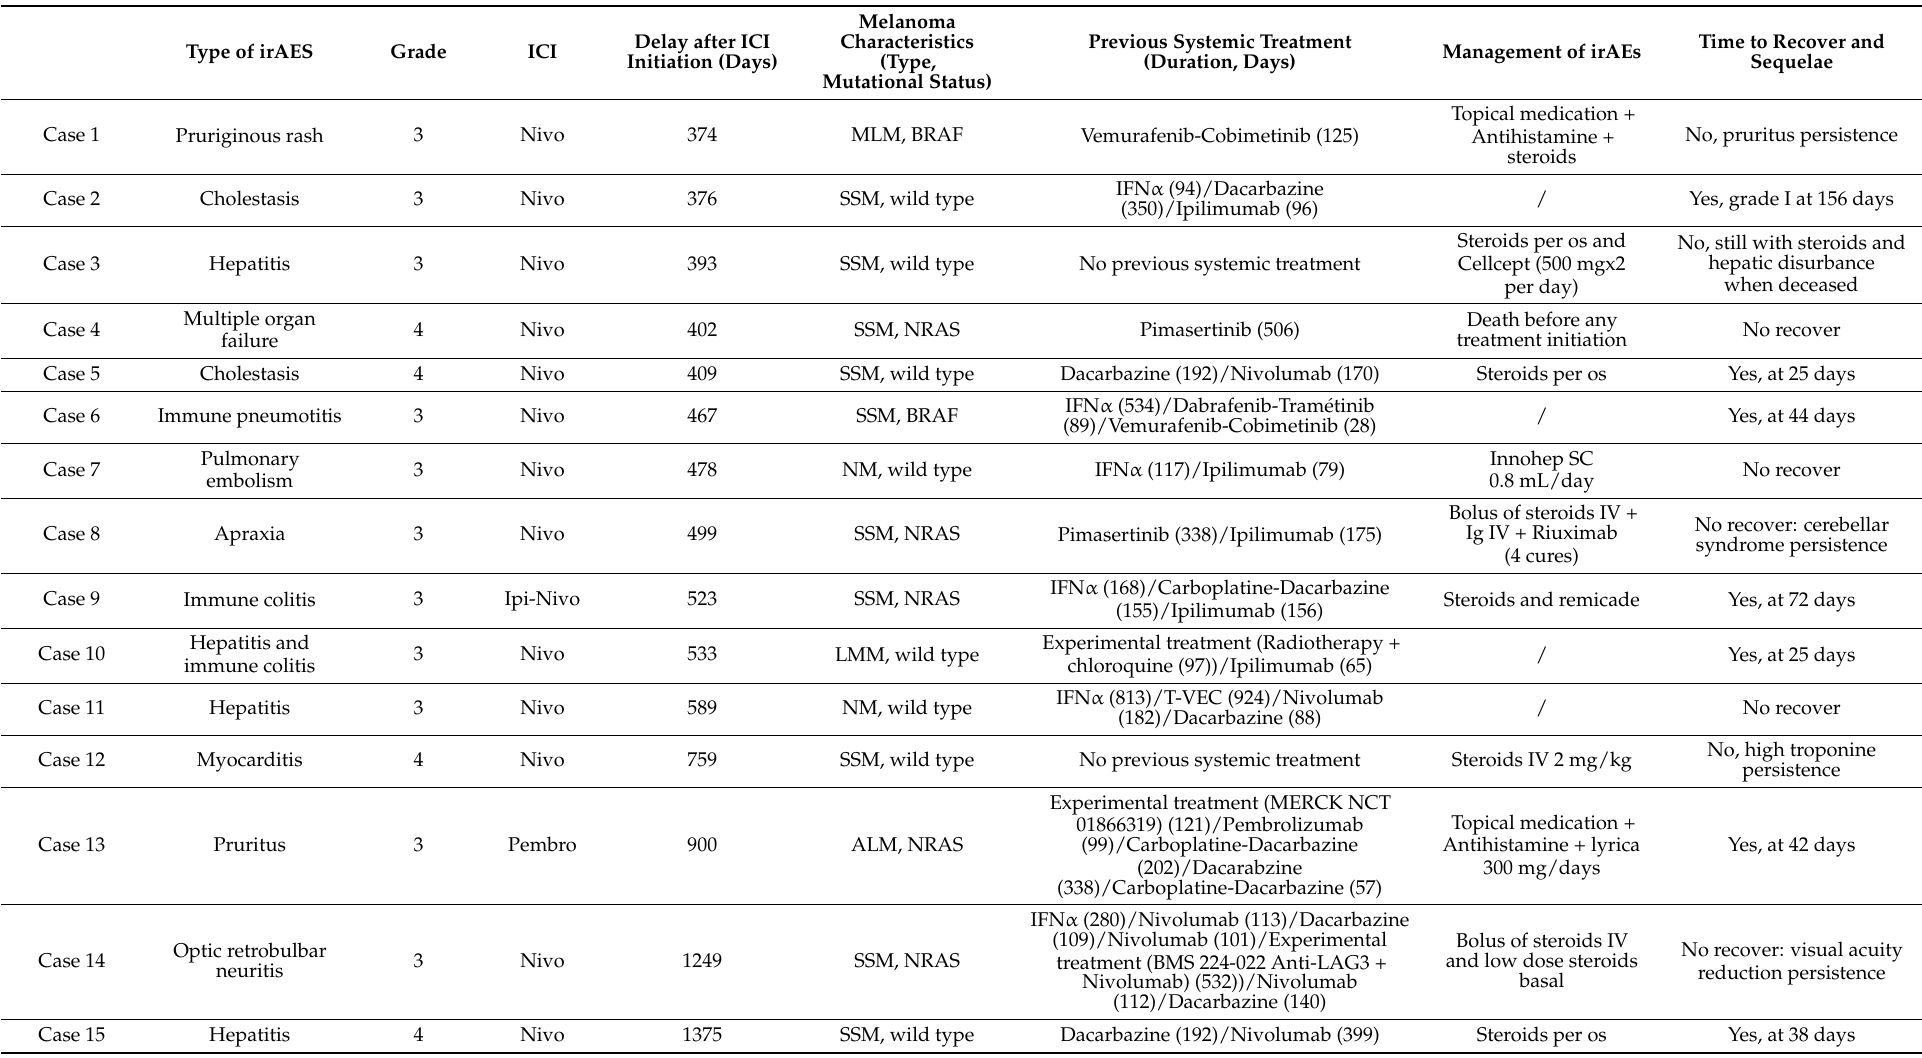
Table 3. Focus on late-onset irAEs (>1 year, n = 15) of which 4 late-onset irAES >2